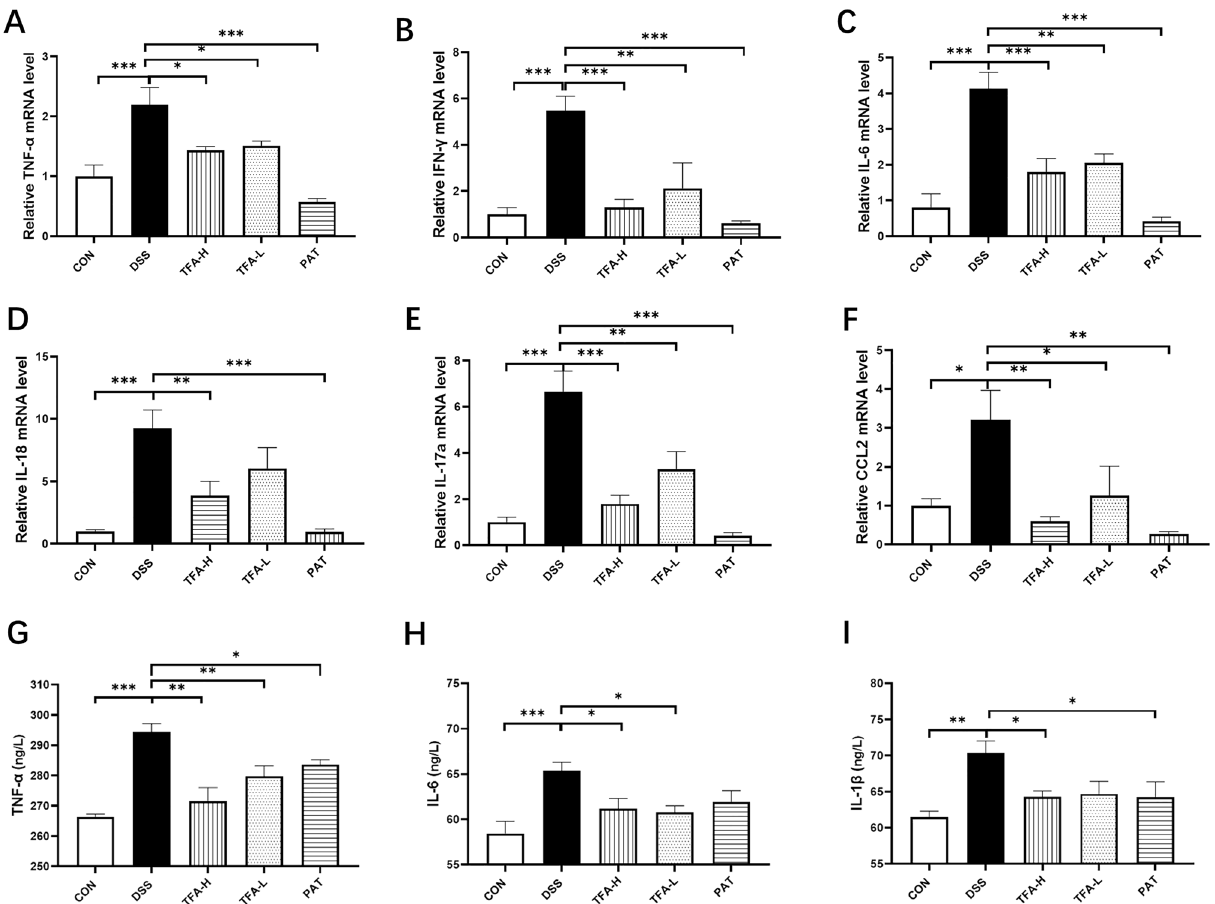
Figure 2. Inflammatory cytokines in the mouse colon after treatment with DSS and administration of TFA and PAT. ( A – F ) mRNA quantification of proinflammatory cytokines (TNF‑α, IL‑6, IFN‑γ, IL‑18 and IL‑17a)